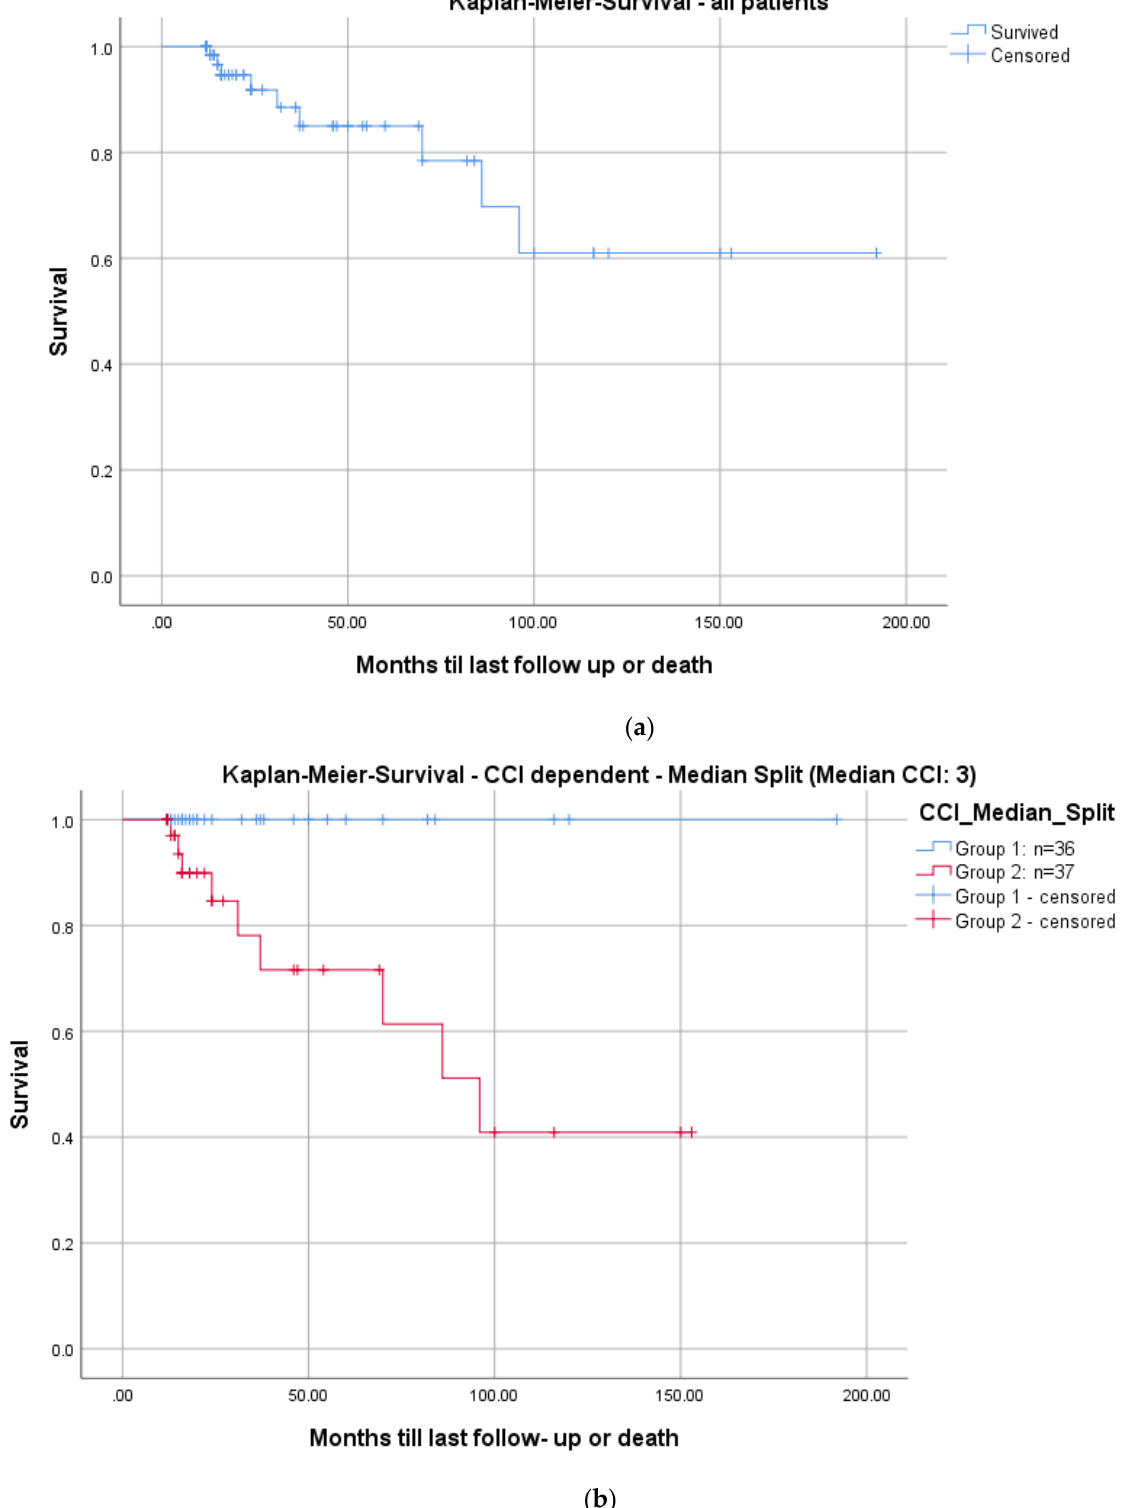
Figure 7. Kaplan–Meier survival curves for all patients ( a ) and differentiated by comorbidities determined with a median split of the CCI: CCI ≤ 3; n = 36 (blue graph) and > 3; n = 37 (red graph), log-rank test: p = 0.005 ( b ).